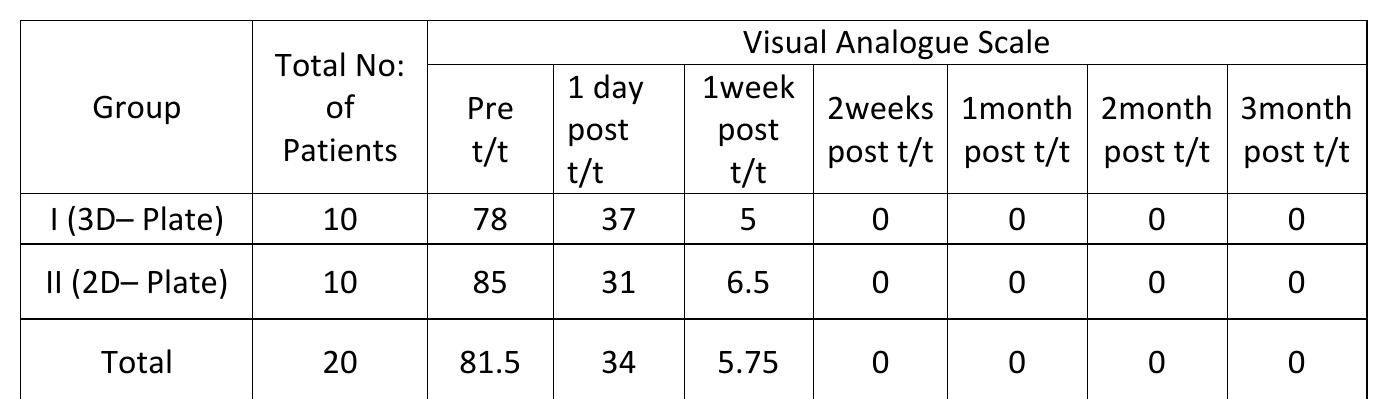
Table 7: Pain on Visual Analogue Scale